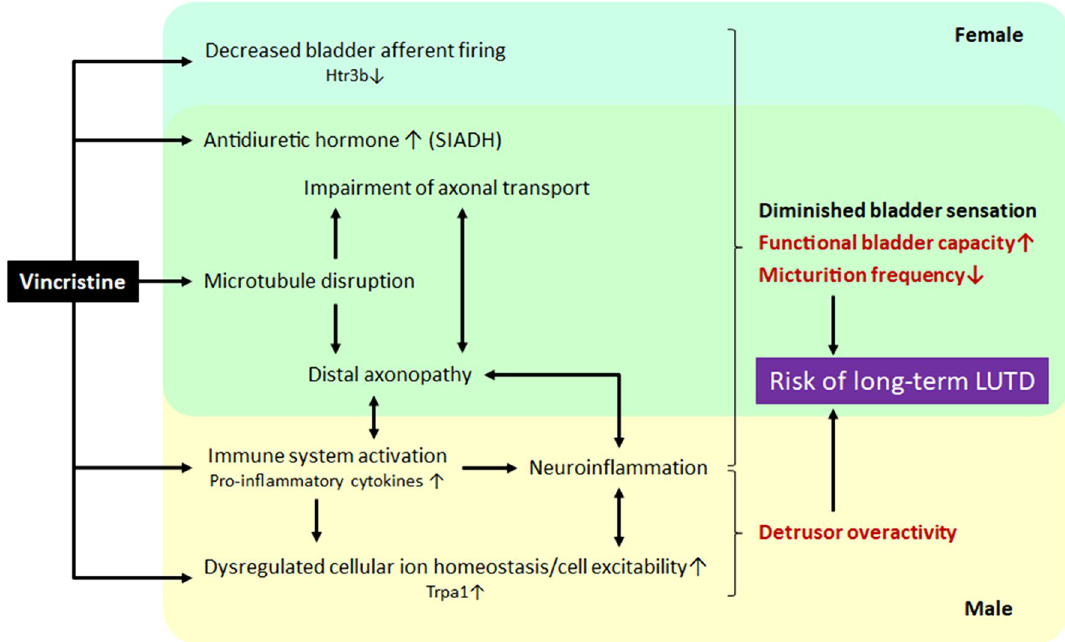
Figure 8. Schematic diagram of the proposed mechanisms underlying vincristine induced alterations in lower urinary tract function. Systemic VCR exposure induces deficiency in bladder sensation, leading to a decrease in micturition frequency accompanied with an increased bladder capacity. In addition to the VCR- induced impairments of axonal transport and distal axonopathy, sexual dimorphic mechanisms contribute to the phenotype; in females, a decrease in bladder afferent firing through downregulation of Htr3b signaling while in males, neuroinflammation. Syndrome of inappropriate secretion of antidiuretic hormone (SIADH) can exacerbate the symptoms. In males, the dysregulations of cellular ion homeostasis in the bladder through enhanced Trpa1 signaling induce increases in cell excitability, leading to detrusor overactivity. The VCR-induced neuroinflammation also can play a role in detrusor overactivity in male. Systemic VCR exposure can increase risk of developing long-term sex specific LUTD via multiple